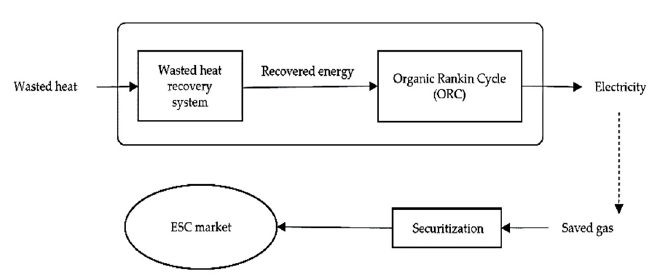
Figure 6. The schematic view of the certificate issuance process based on a performed project by ORC (Source: authors conception).